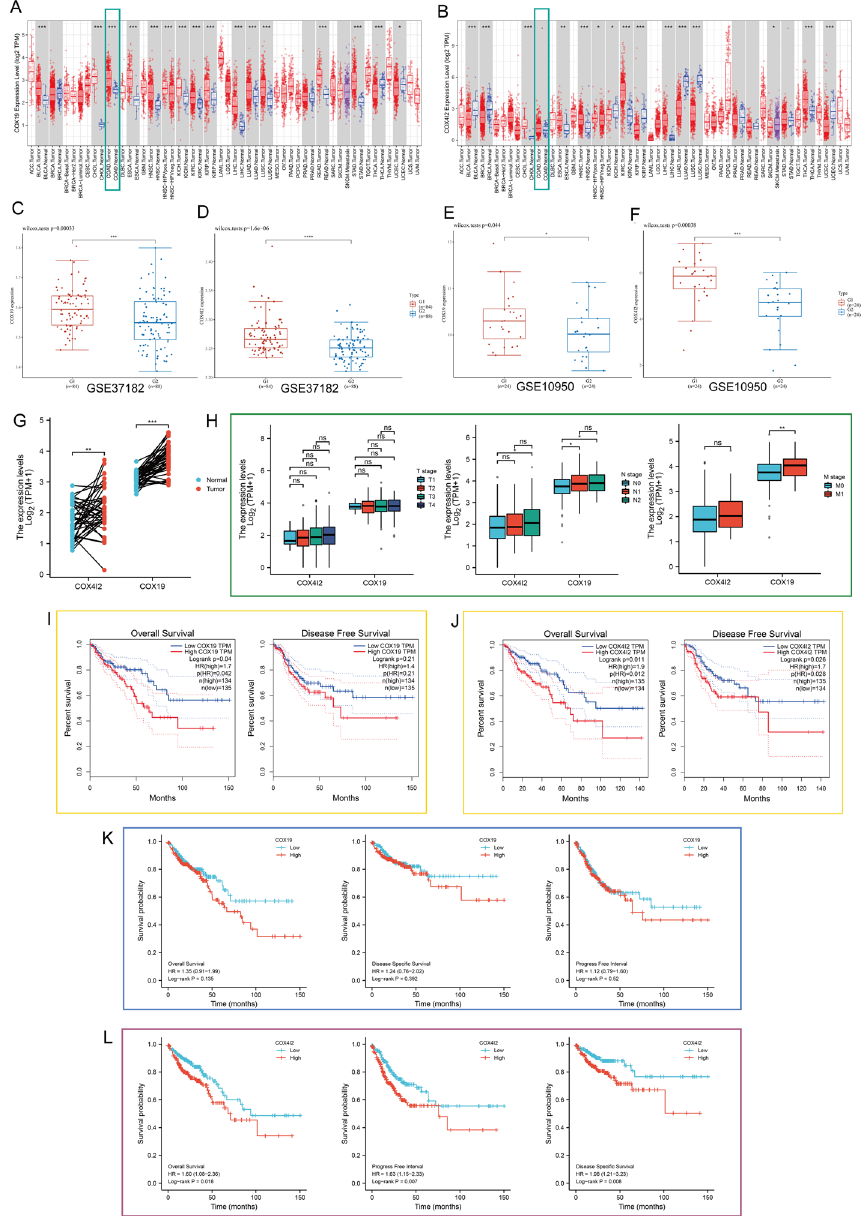
Fig. 2 Expression of COX19 and COX4I2 in relation to clinical features of CRC. a , b COX19 ( a ) and COX4I2 ( B ) mRNA levels in various human tumor and normal tissues, from the TIMER database ( n 480). c , d Dataset = GSE37182 ( n 172) from the GEO showing COX19 ( c ) and COX4I2 ( d ) mRNA levels in CRC. Wilcoxon test = was performed. e , f Dataset GSE10950 ( n 48) from GEO showing COX19 ( e ) and COX4I2 ( f ) mRNA levels in = CRC. Wilcoxon test was performed. g Expression of COX19 and COX4I2 in CRC, from TCGA‑COAD ( n 41). = h Association of COX19 and COX4I2 mRNA levels with the T (Tumor) ( n 477), N (Node) ( n 478), and M = = (Metastasis) ( n 411) stages. i , j Correlation of COX19 ( i ) and COX4I2 ( j ) levels with CRC patient OS and DFS, = from the the GEPIA database ( n 269). k , l The overall survival, progression‑free interval, and disease‑specific = survival from the TCGA‑COAD data in relation to COX19 ( k ) and COX4I2 ( l ) expression ( n 477). Asterisks = indicate significant difference at * P < 0.05, ** P < 0.01, *** P < 0.001, **** P < 0.0001; ns , not significant. GEO Gene Expression Omnibus, mRNA messenger; for other Abbreviations, see Abbreviation